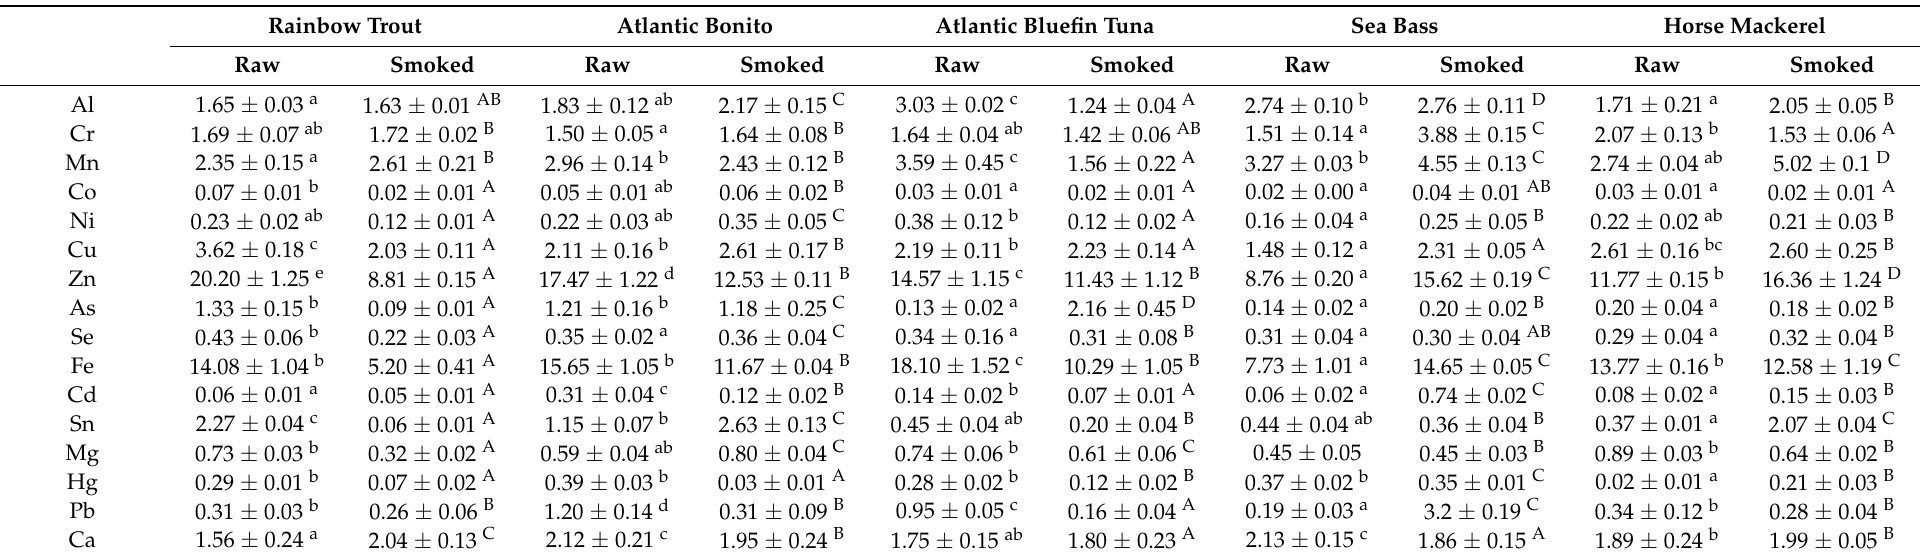
Table 4. Elemental profile of raw and smoked fish samples (mg/kg). Rainbow Trout Atlantic